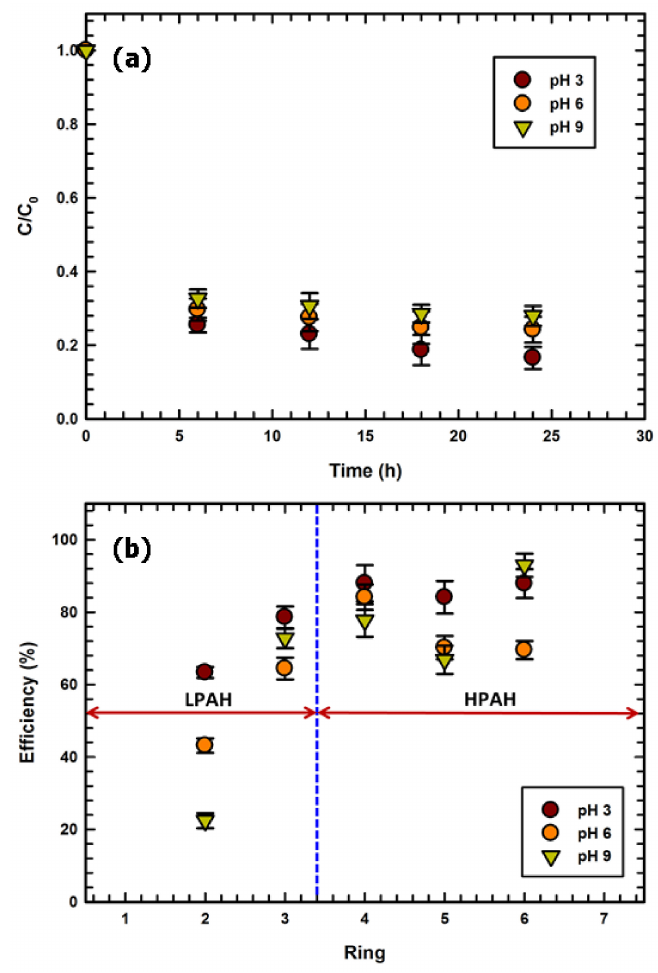
Figure 6. ( a ) Effect of initial pH and ( b ) efficiency of PAH degradation as function of ring number for various initial pH levels. Experimental conditions: amount of sediment = 1.00 g, reaction volume = 40 mL, T = 303 K, [Na 2 S 2 O 8 ] = 2 × 10 − 5 M, [Fe 3 O 4 –WB] = 3.33 g/L, and molar ratio of PS: ∑ PAHs =